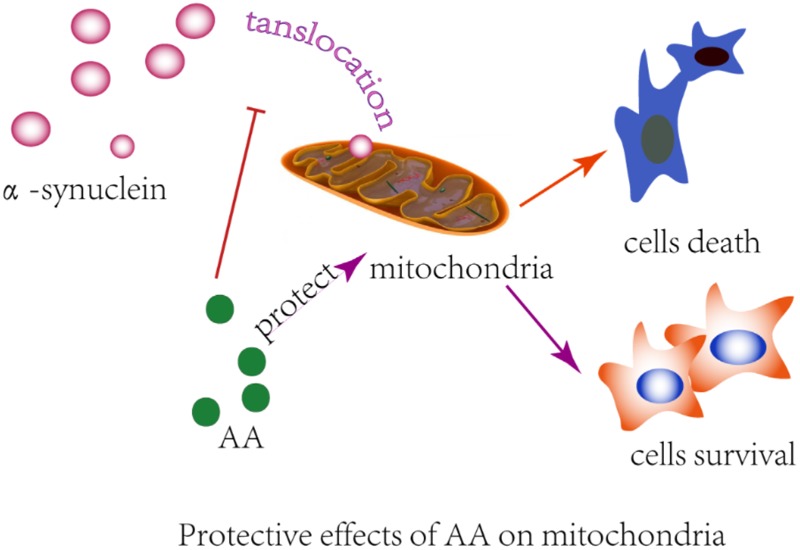
Illustration of the protective effects of AA in α-syn- and rotenone-induced PD-like models. AA may maintain the integrity of the mitochondrial membrane and then block α-syn importation into mitochondria.